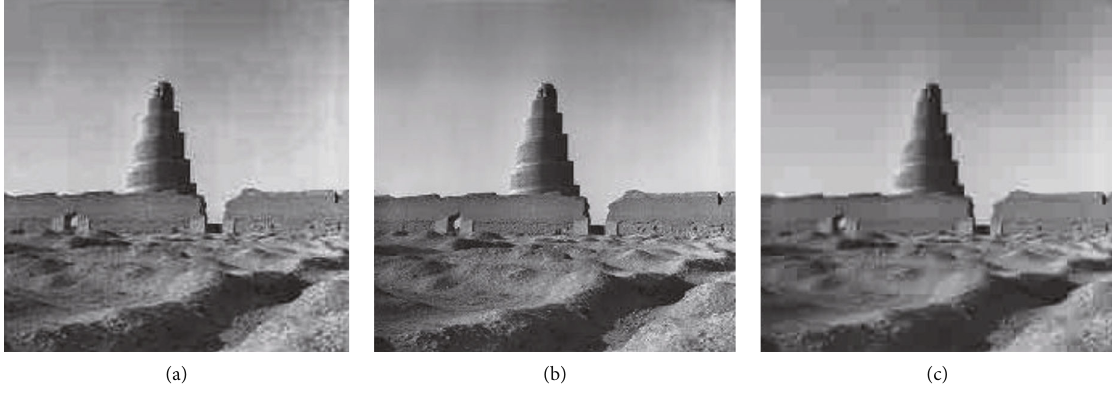
Figure 6: Test image, left to right: (a) JPEG, (b) JPEG 2000, and (c) EED